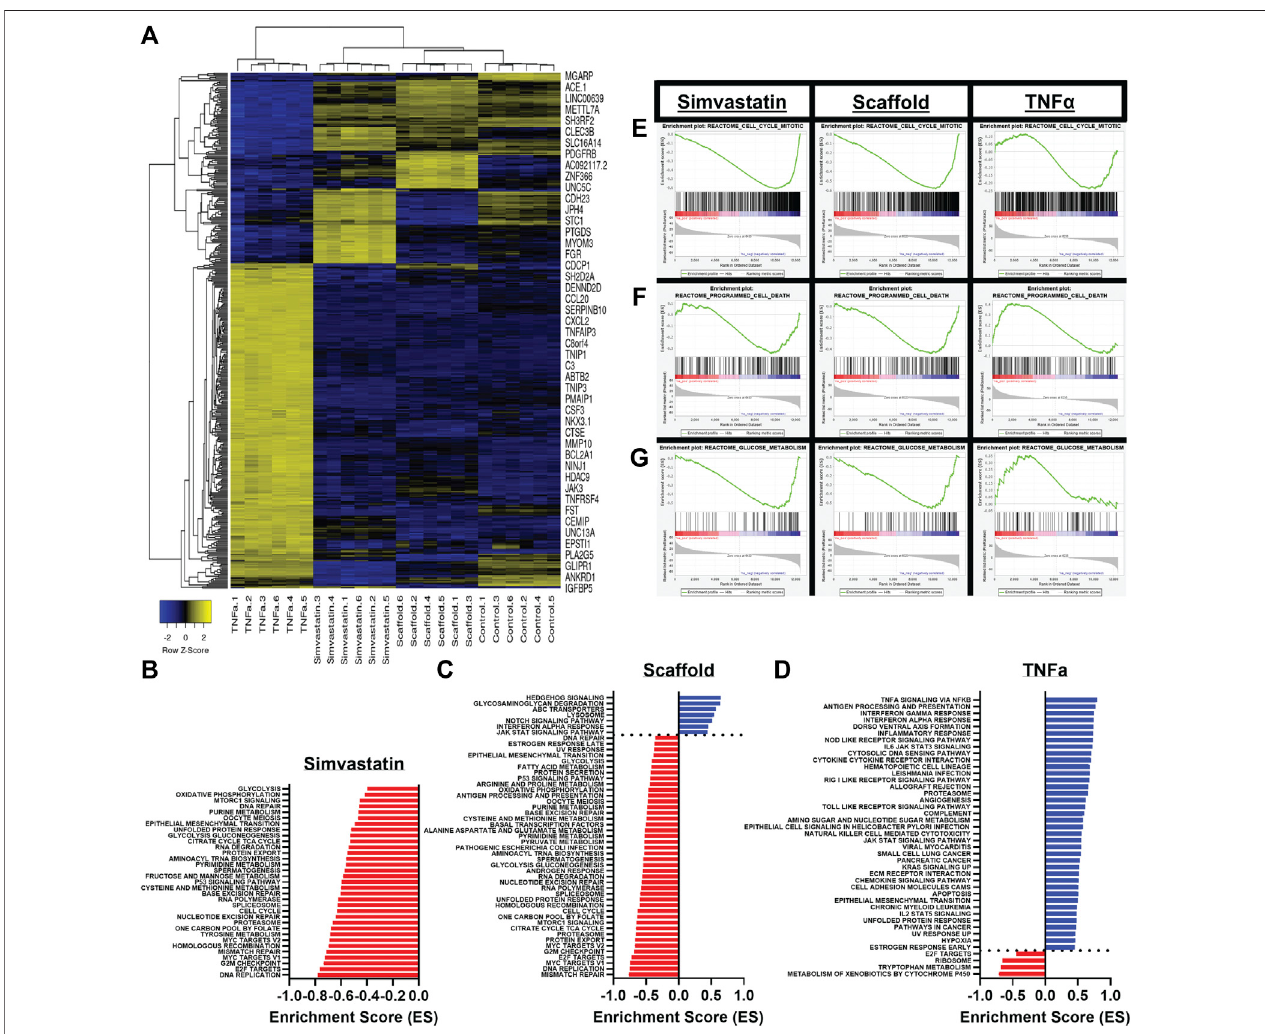
FIGURE 4 | Differential gene expression and the gene set enrichment analysis of scaffold seeded, simvastatin-, and TNF α -treated hAECs. (A) Heatmap of all 415 identi fi ed signi fi cantly differentially expressed genes across all three treatment groups. (B – D) Signi fi cantly enriched pathways in the KEGG and HALLMARK gene sets followingGSEAforsimvastatin (B) ,scaffold (C) ,andTNF α (D) groups. (E – G) RepresentativeGSEAplotsacrossallthreegroupsforthreebiologicallyrelevantpathways, including mitosis (E) , programmed cell death (F) , and glucose metabolism (G) .